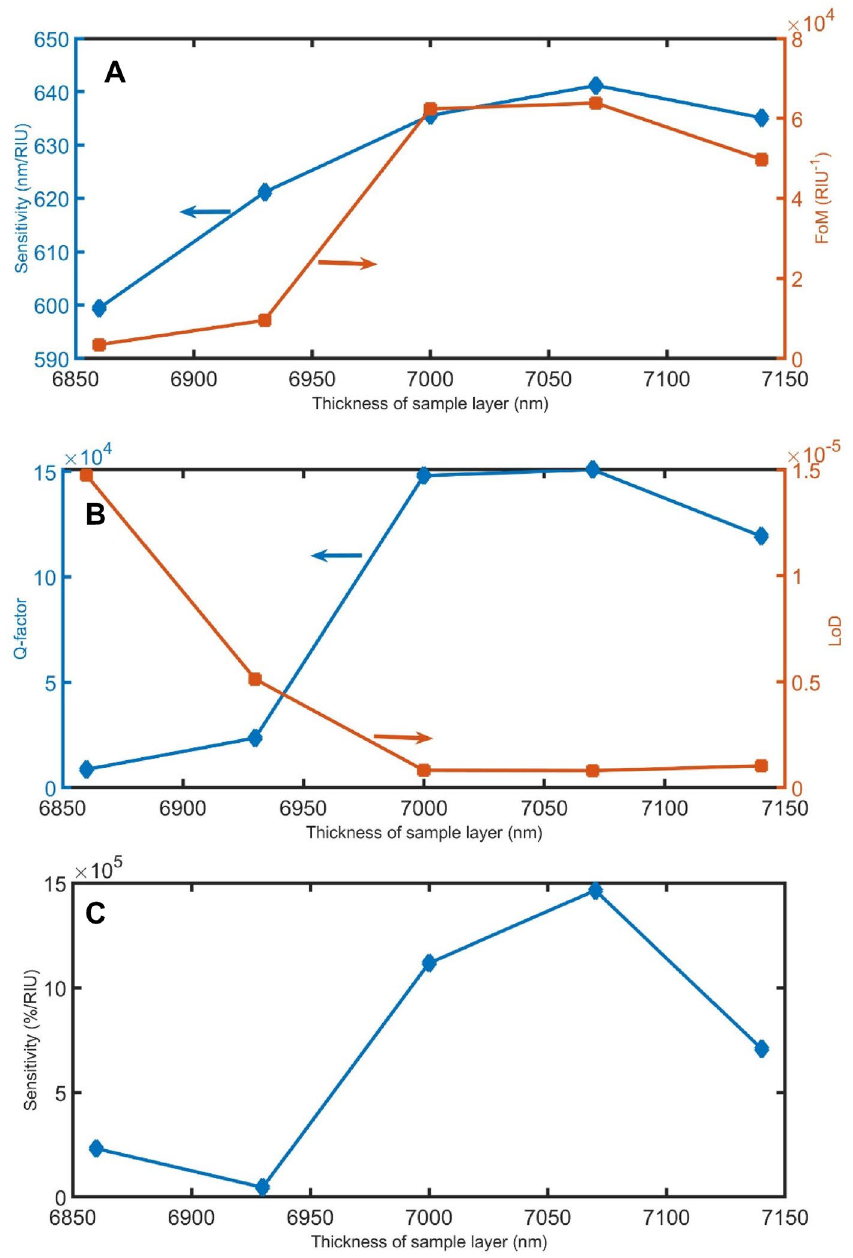
Figure 11. The ( A ) sensitivity in nm/RIU and FoM, ( B ) Q-factor and LoD, and ( C ) sensitivity in %/RIU, with varying d sample